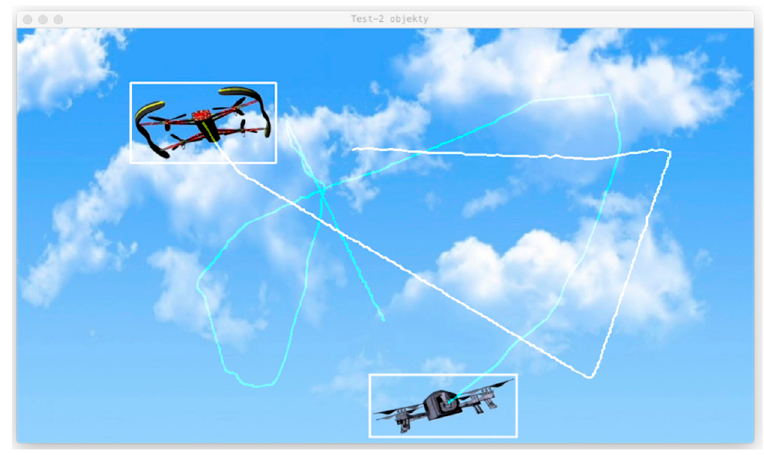
Figure 9. Movement and tracking of multiple objects using the ORB detector.